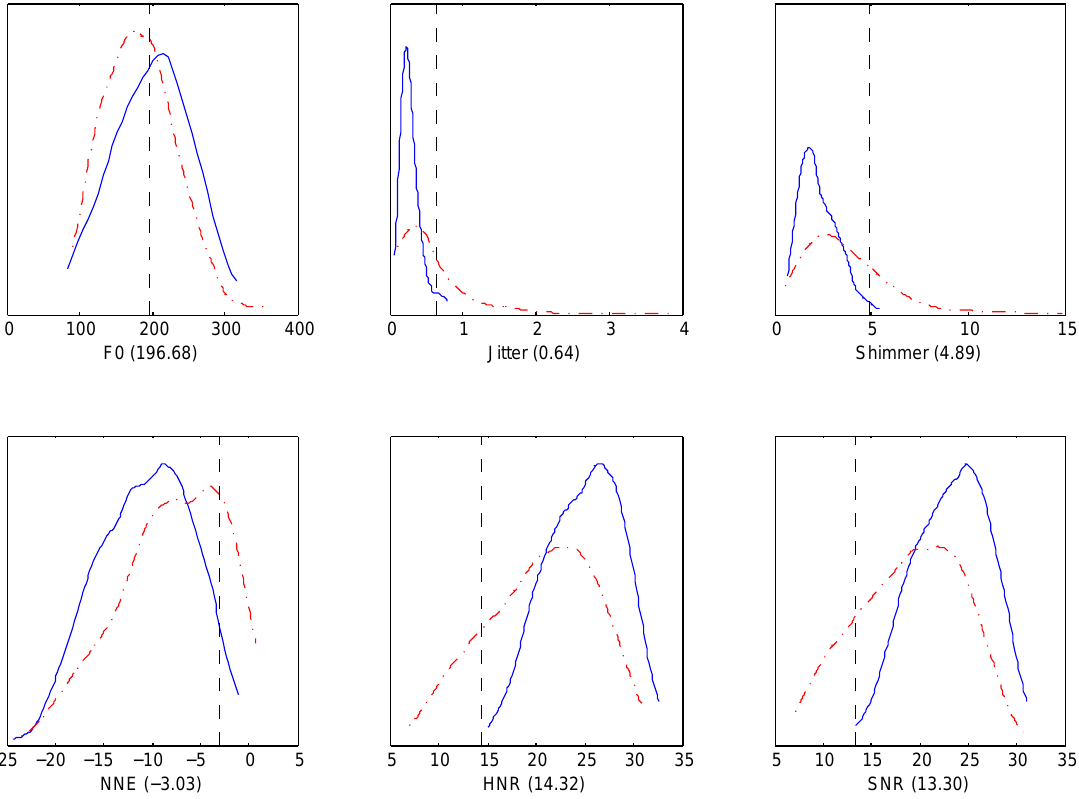
Figure 1. Probability ( y -axis) density functions of audio parameters of healthy (blue) and pathological (red, dashed-dotted) cases. A dashed line and numbers in the parentheses correspond to a parameter value of a subject randomly selected from the database used to train the developed